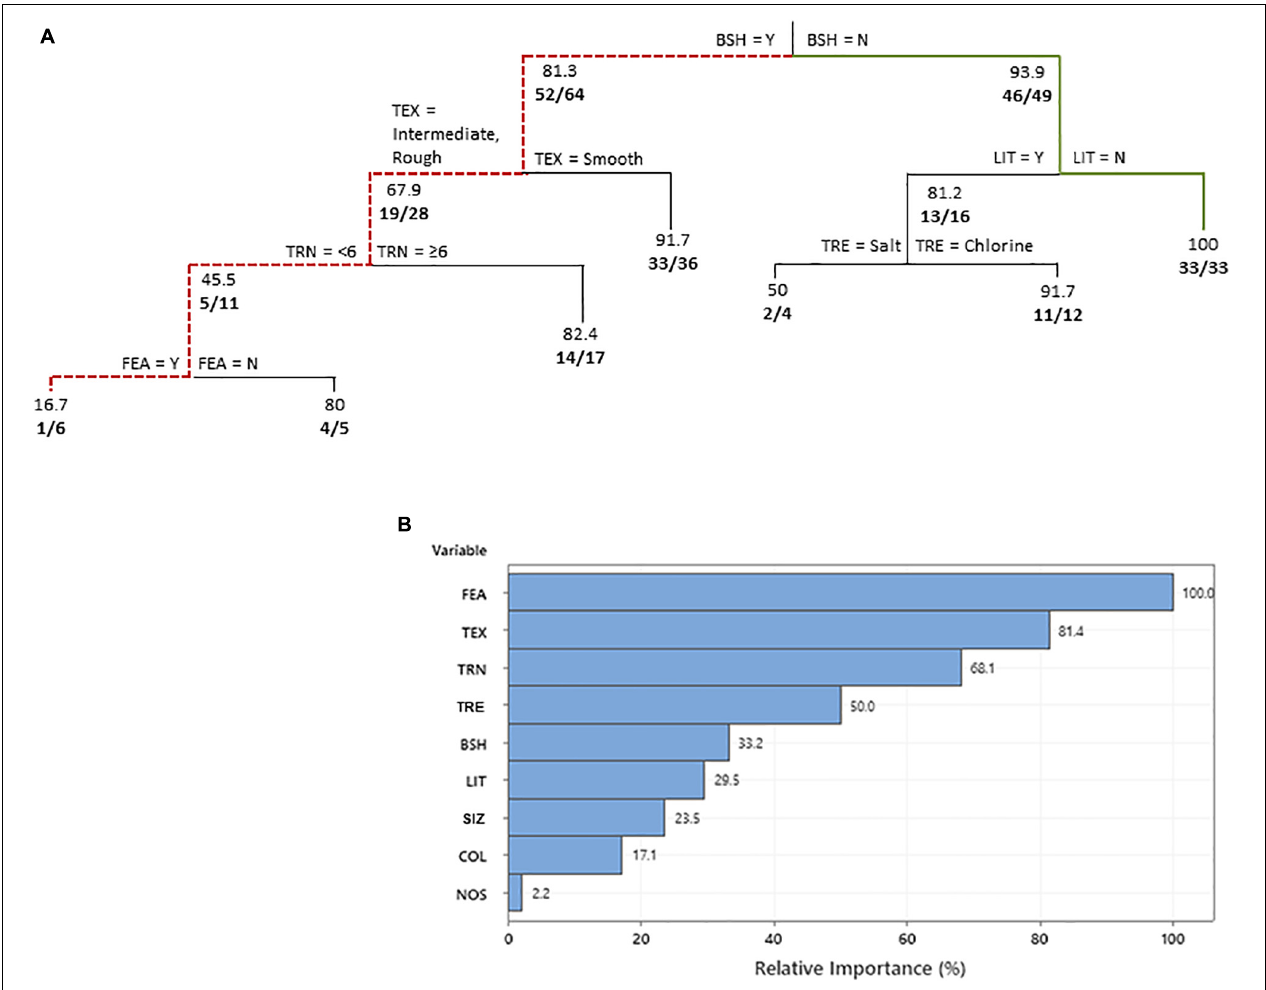
FIGURE 2 | Classification tree (A) predicting the swimming pool characteristics that influenced bat activity observed around the properties and backyards of residents in a suburban neighborhood in Fort Worth, TX, United States. The variable predictors that create a split are labeled at each branch split. Below each node values represent the percentage of responses in which bats were observed and number of positive responses along with the total number of responses considered are given in bold. A bold solid green line shows the combination of independent variables that led to the most observations and a red dotted line shows the variables resulting in the least observations. Relative variable importance chart (B) with relative importance defined as % improvement with respect to the top predictor. FEA, connected hot tub/fountain/waterfall feature present; TEX, pool interior texture; TRN, number of trees visible from the pool; TRE, pool treatment; BSH, bushes/shrubs and structures ( < 2 m) close to or bordering pool; LIT, pool lighting (LIT); SIZ, surface area of swimming pool m 2 ; COL, color of pool interior; and NOS, high frequency noises generated between 7 pm and 6